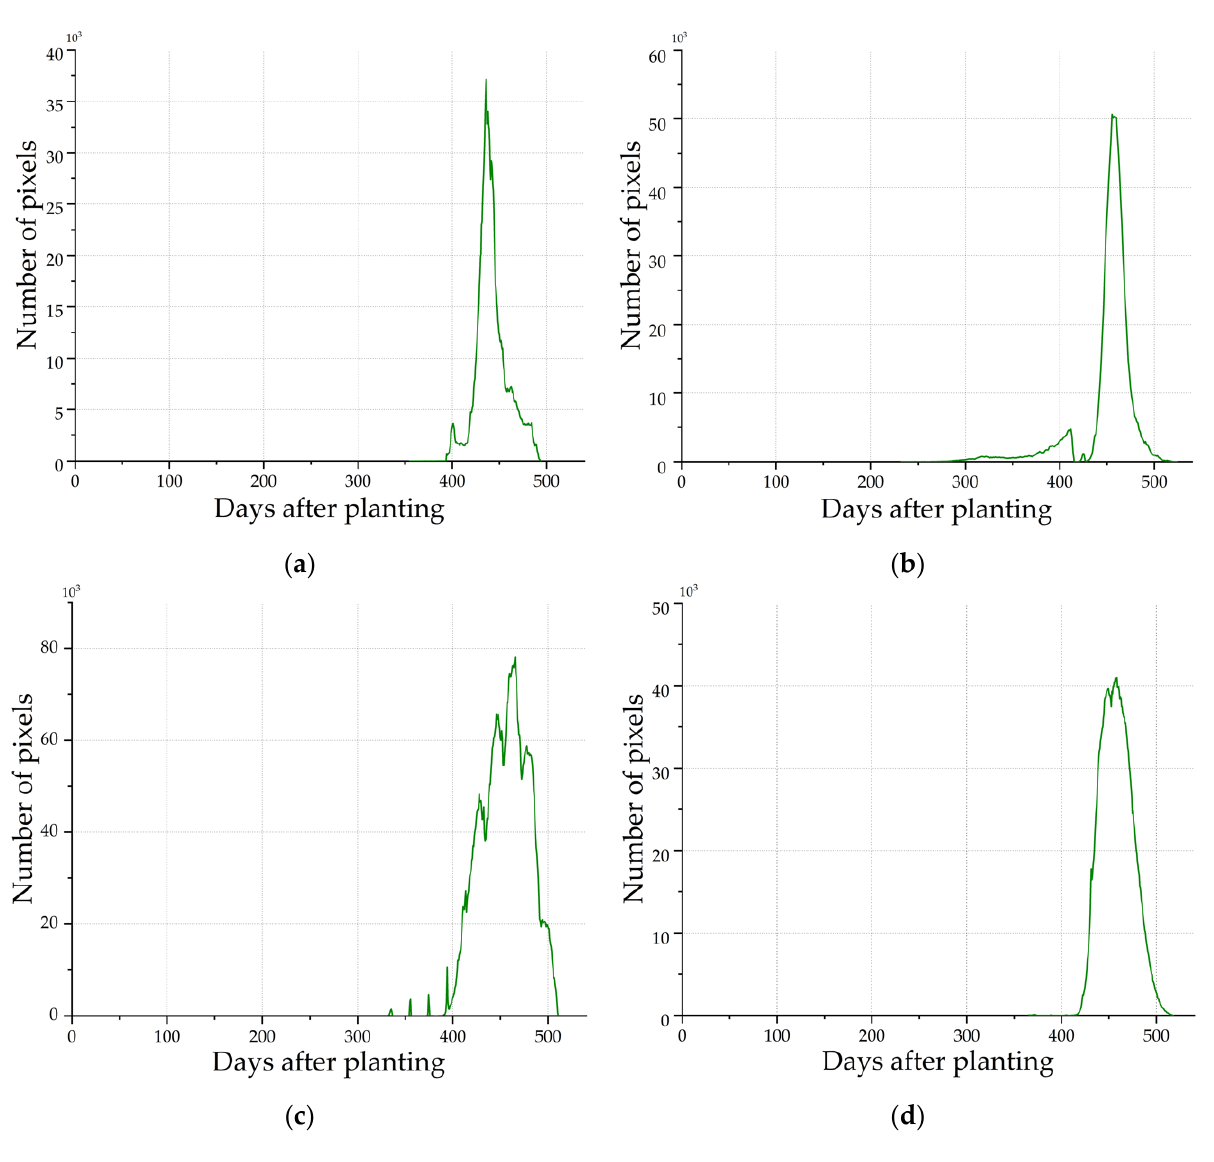
Figure 20. Histograms of areas ( a ) 2, ( b ) 4, ( c ) 6, and ( d ) 7.